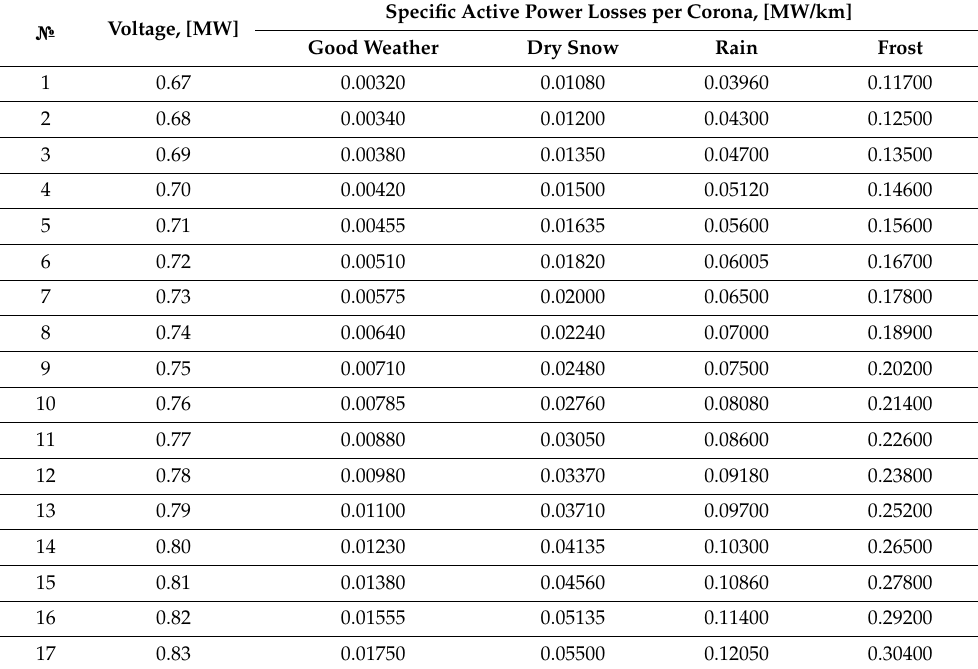
Table 1. Specific active power losses per corona at various voltage values on the 750 kV power transmission line Vinnitsa-Zapadno-Ukrainskaya for typical weather